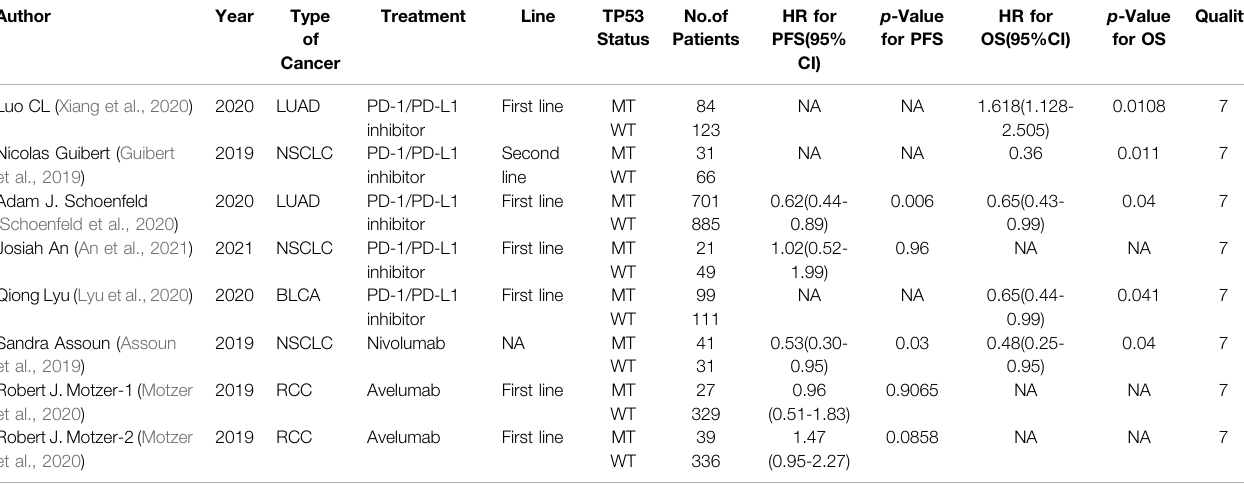
TABLE 2 | Basic characteristics of included studies with TP53 status.